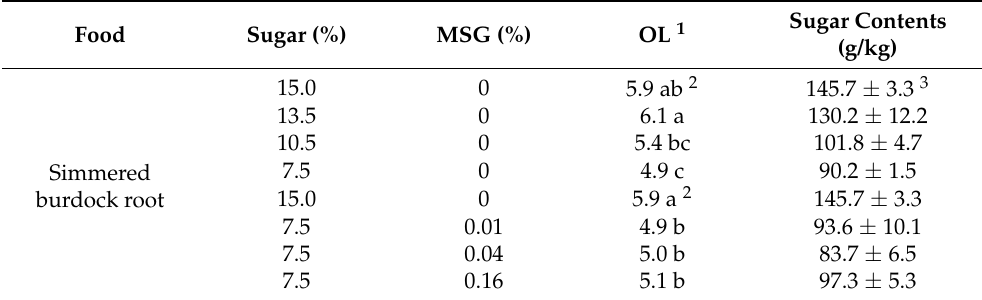
Table 2. Consumer overall liking and sugar contents of simmered burdock root containing various concentrations of sugar or sugar with